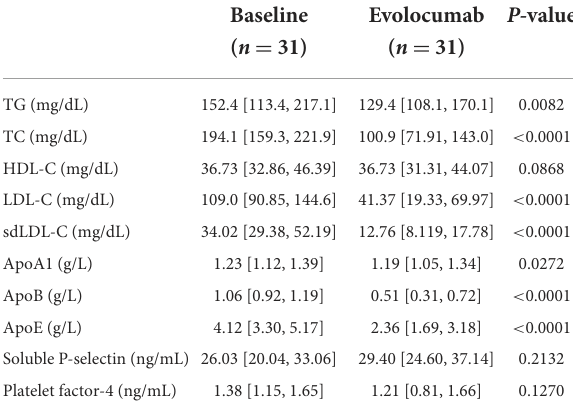
TABLE 2 Lipid profiles and platelet activation markers of patients with ACS at baseline and 72h post-evolocumab administration.